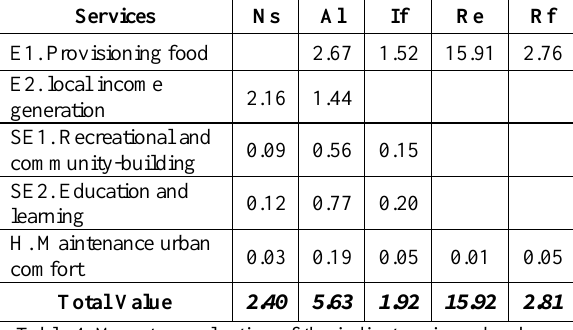
Table 4. Monetary valuation of the indicators in each urban farming form in USD per m 2 annually (Ns: Nursery; Al: Allotment; If: Institutional; Re: Residential; and Rf: